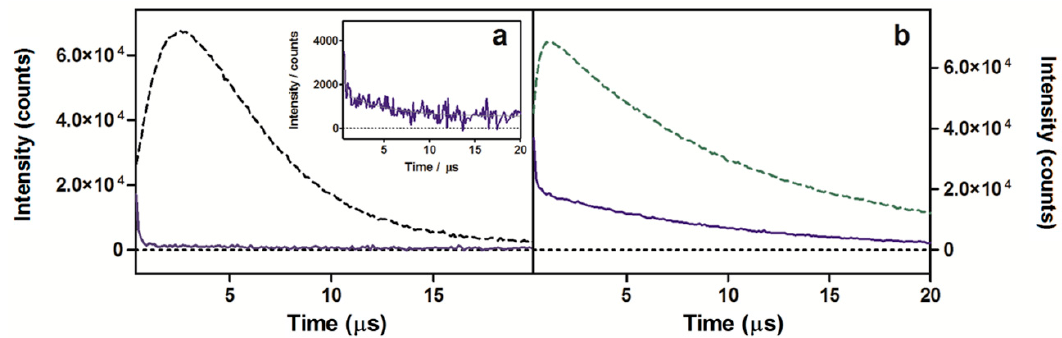
Figure 2. 1 O 2 phosphorescence signals observed at 1275 nm for optically matched solutions at 532 nm of porphycene 2 (blue solid lines) and reference PSs (green dashed lines) in water ( a ) or in MeOH ( b ). Inset: signal magnification of 2 in water. 5,10,15,20-tetrakis( m -hydroxyphenyl)-21H,23H-porphine ( m -THPP) in MeOH ( a ) and 5,10,15,20-tetrakis( N -methyl-4-pyridyl)-21H,23H-porphine (TMPyP) in water ( b ) are the chosen reference PSs.